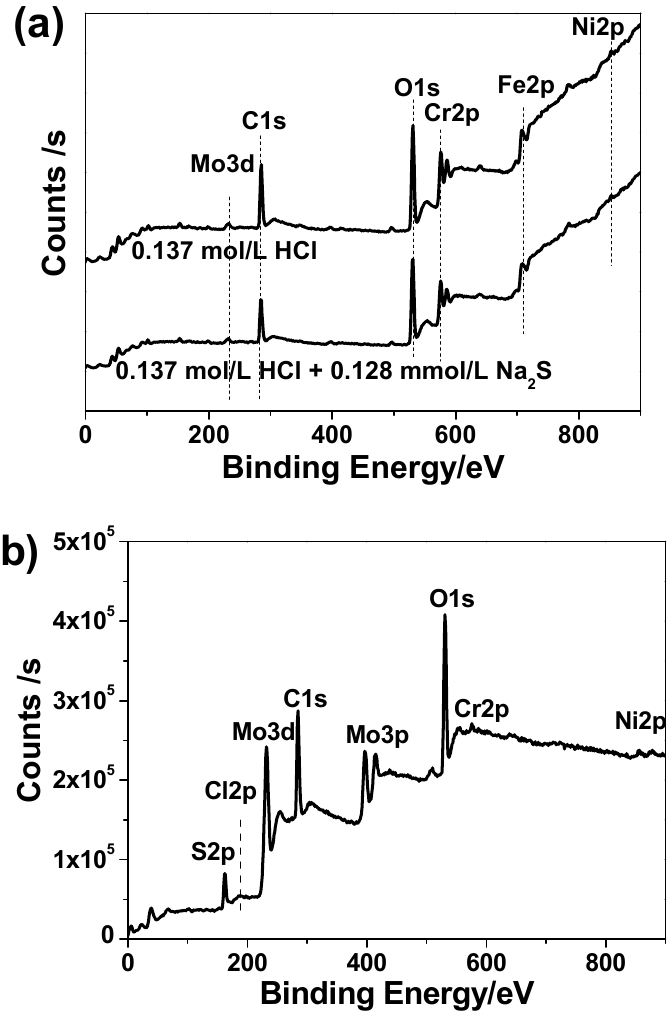
Figure 7. Large scale scanning XPS spectra of ( a ) passive films on 2205 DSS surface in 0.137 mol/L HCl solution and 0.137 mol/L HCl solution with 0.128 mmol/L Na 2 S, ( b ) corrosion product film on 2205 DSS surface in 137 mol/L HCl solution with 0.385 mmol/L Na 2 S at 90 °C for 8 h.